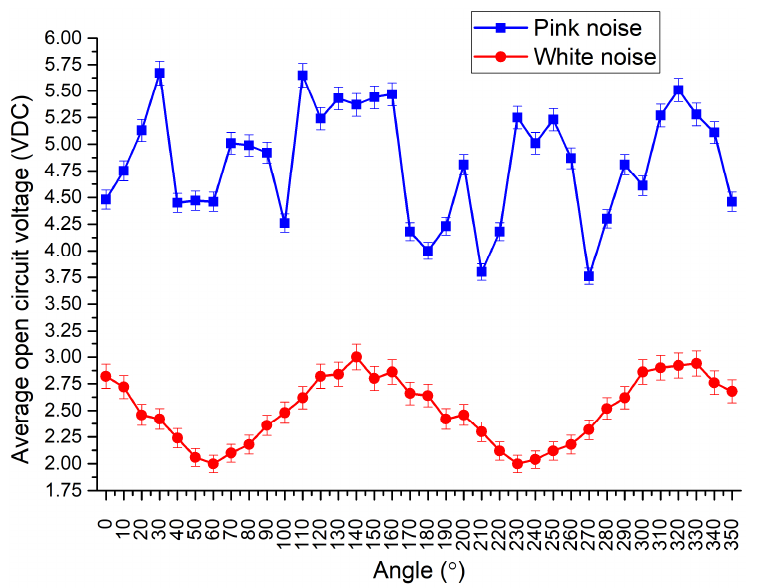
Figure 17. OCV—angle of excitation characteristics of energy harvester while input vibrations are random.